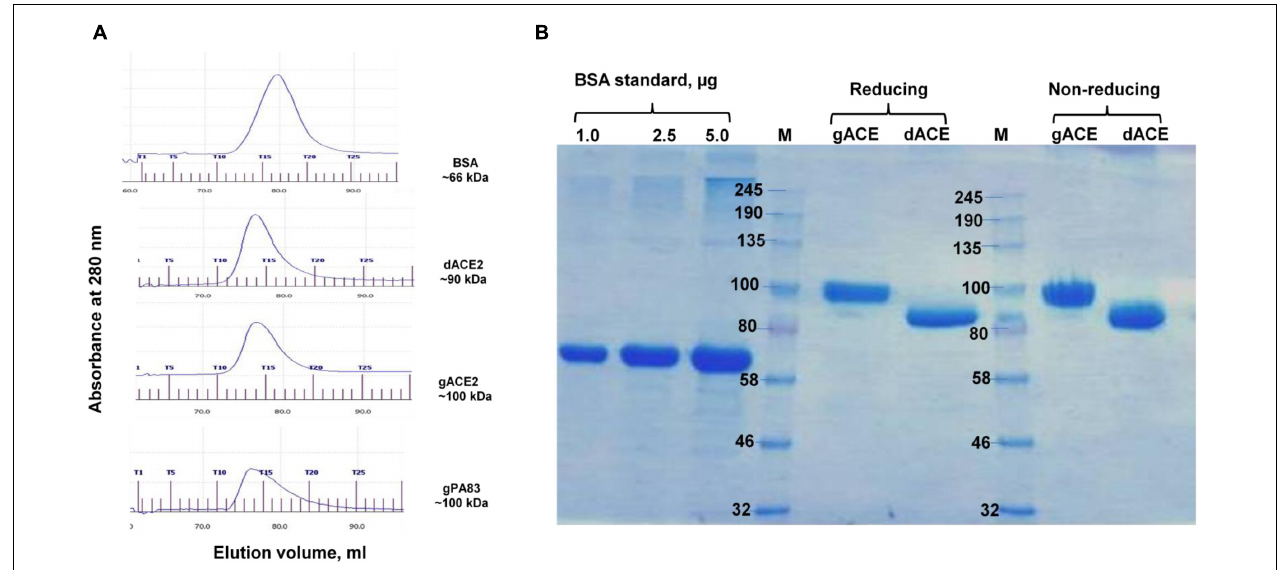
FIGURE 3 | Gel filtration chromatography (A) and SDS-PAGE (B) of plant-produced gACE2 or dACE2 proteins, eluted from Sephacryl R (cid:13) S-200 HR column. (A) Profiles of BSA, plant-produced gACE2, dACE2, and PA83 proteins, eluted from Sephacryl R (cid:13) S-200 HR column. The column was equilibrated with 50 mM phosphate buffer (with 150 mM NaCl, pH 7.4). BSA, plant-produced dACE2, gACE2, and gPA83 proteins, purified using His-tag affinity chromatography, were loaded onto columns. Gel filtration was performed with ÄKTA start using C 10/40 column (cat. no. 19-5003-01, GE Healthcare, Chicago, IL, United States), packed with Sephacryl R (cid:13) S-200 HR (cat. no. 17-0584-10, GE Healthcare). gPA83: plant produced, glycosylated PA83 of B. anthracis , produced in our laboratory (Mamedov et al., 2017, 2019a). (B) SDS-PAGE analysis of plant-produced gACE2 and dACE2 proteins eluted from Sephacryl R (cid:13) S-200 HR column, in reducing and non-reducing conditions as indicated. Lanes were loaded with 2.5 µ g gACE2 or